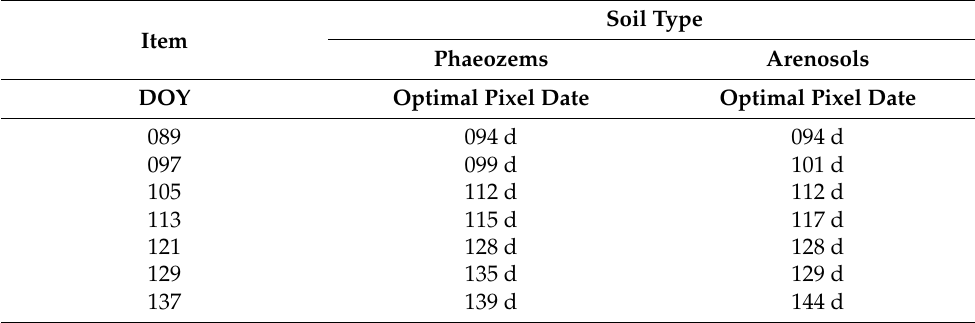
Table 2. Optimal pixel dates of seven image periods for the Phaeozems and Arenosols.